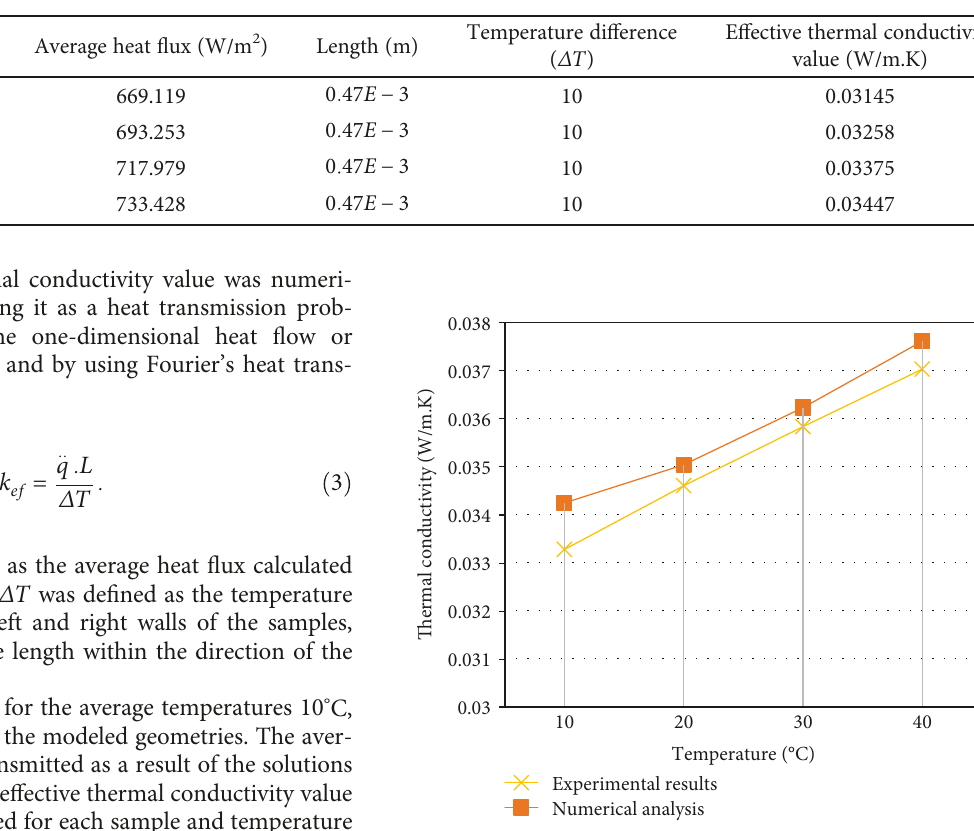
Figure 8: The comparison of the experimental and numerical results for the expanded polystyrene with the density value of 16 kg/m 3